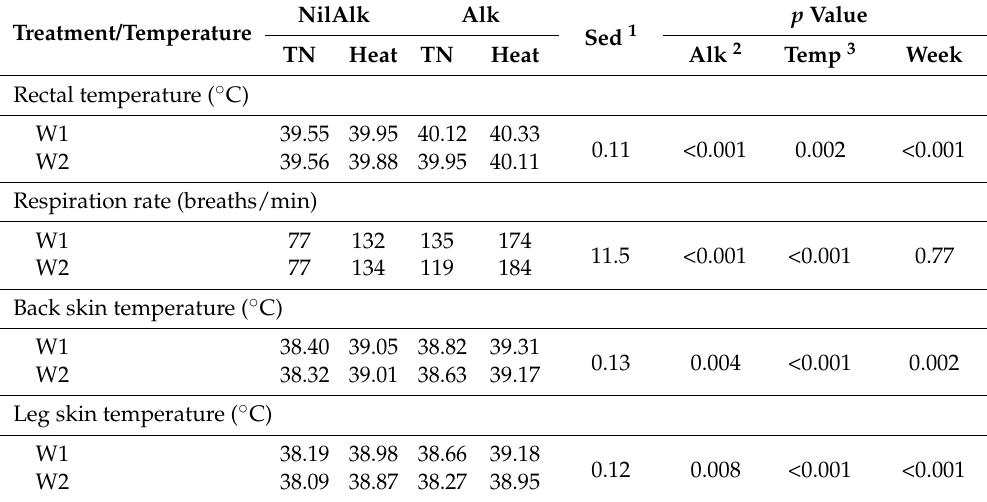
Table 2. Rectal temperature, respiration rate, back skin temperature and leg skin temperature averaged over week 1 and 2 of the experimental period for each